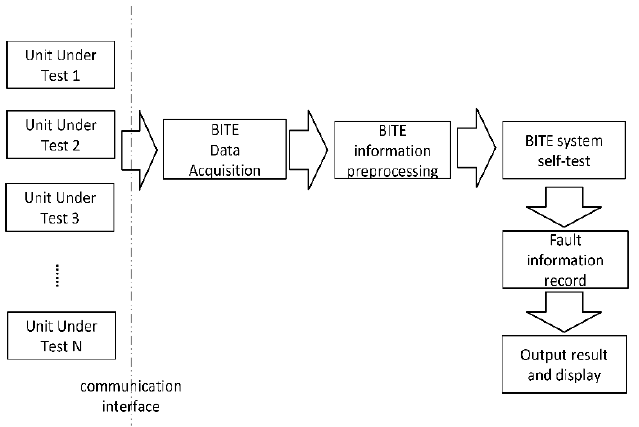
Figure 1. BITE diagnosis flow